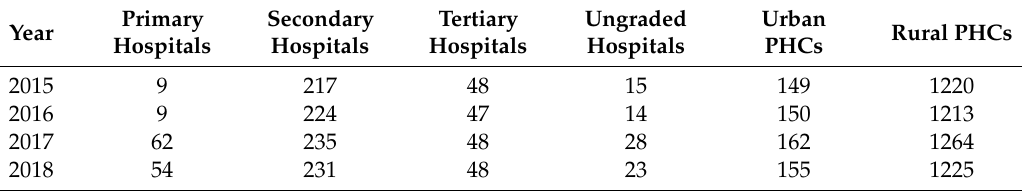
Table 1. Number of healthcare institutions in Shaanxi Province, western China,